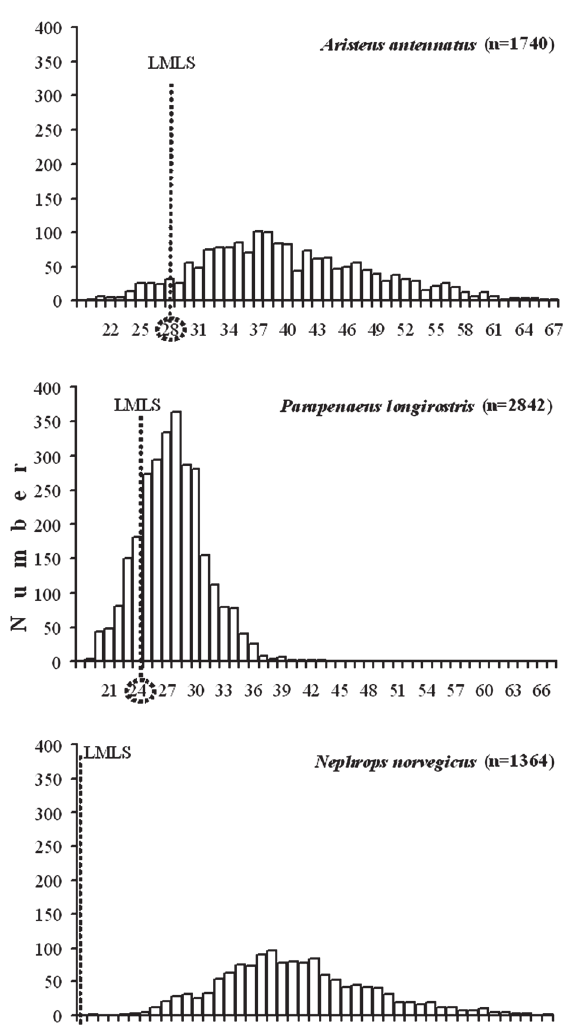
Fig . 6. – length frequency distribution of the crustacean trawl target species (lMls=legal Minimum landing size).